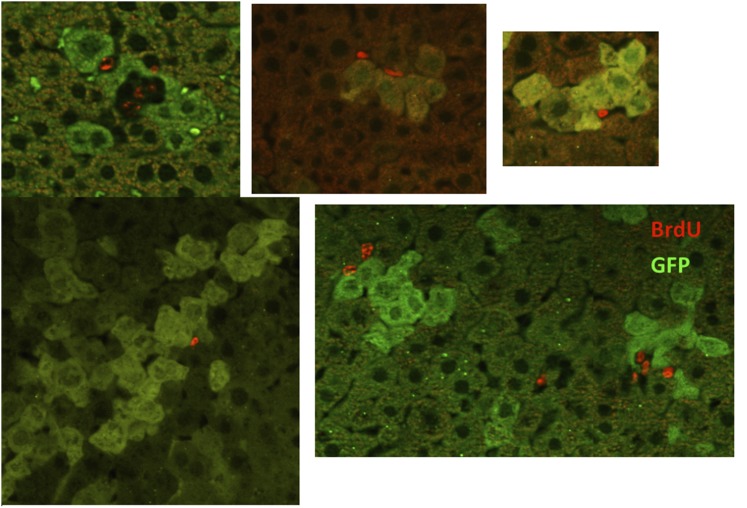
Stromal cells proliferate near Yaphigh hepatocytes